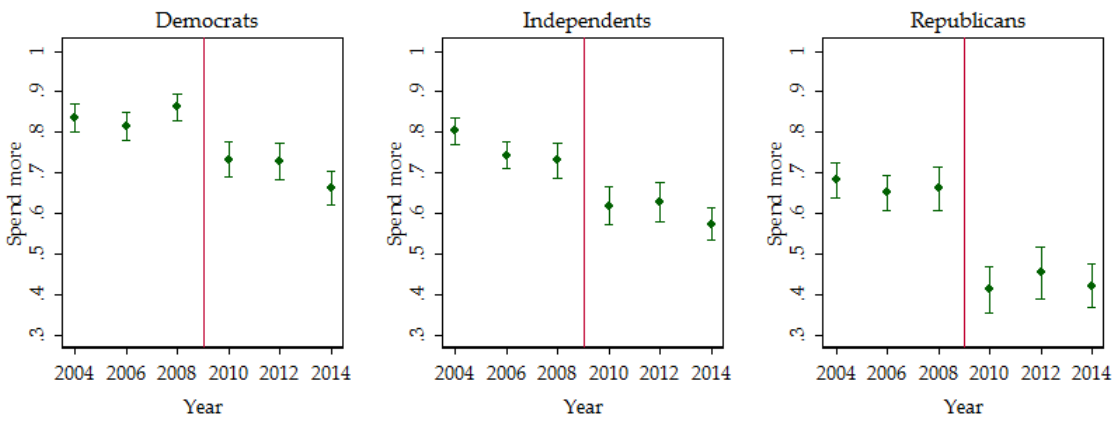
Figure 2: Background-adjusted proportion of respondents, by party identification, who indicate that “too little” money is spent on the nation’s